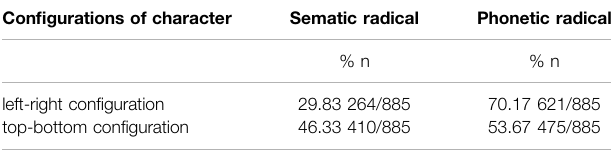
TABLE 3 | The percentage of all children ’ s choices for the identical